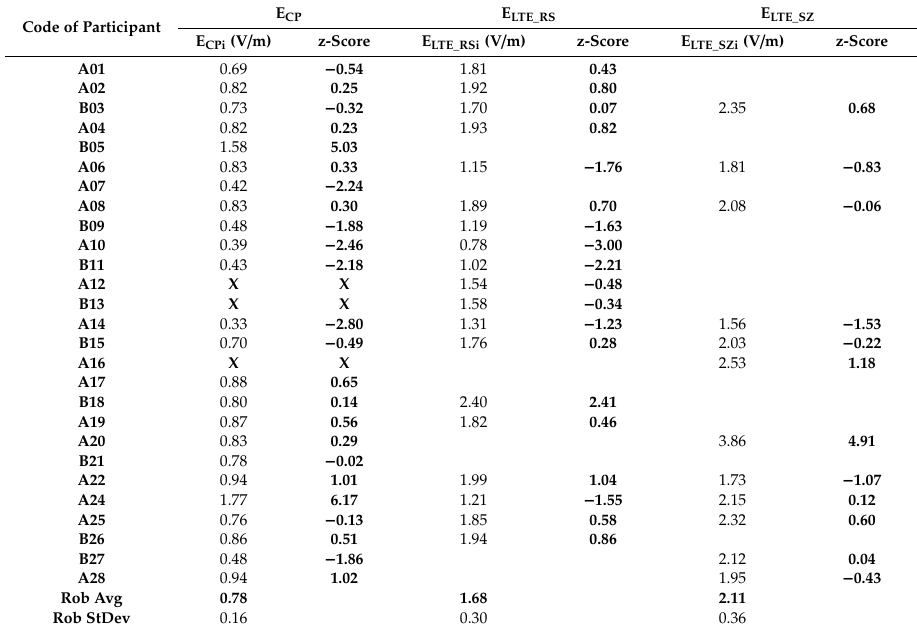
Table 5. Results of sestets and final z-score for each measurement mode (E CP , E LTE_RS , E LTE_SZ ). Code of Participant